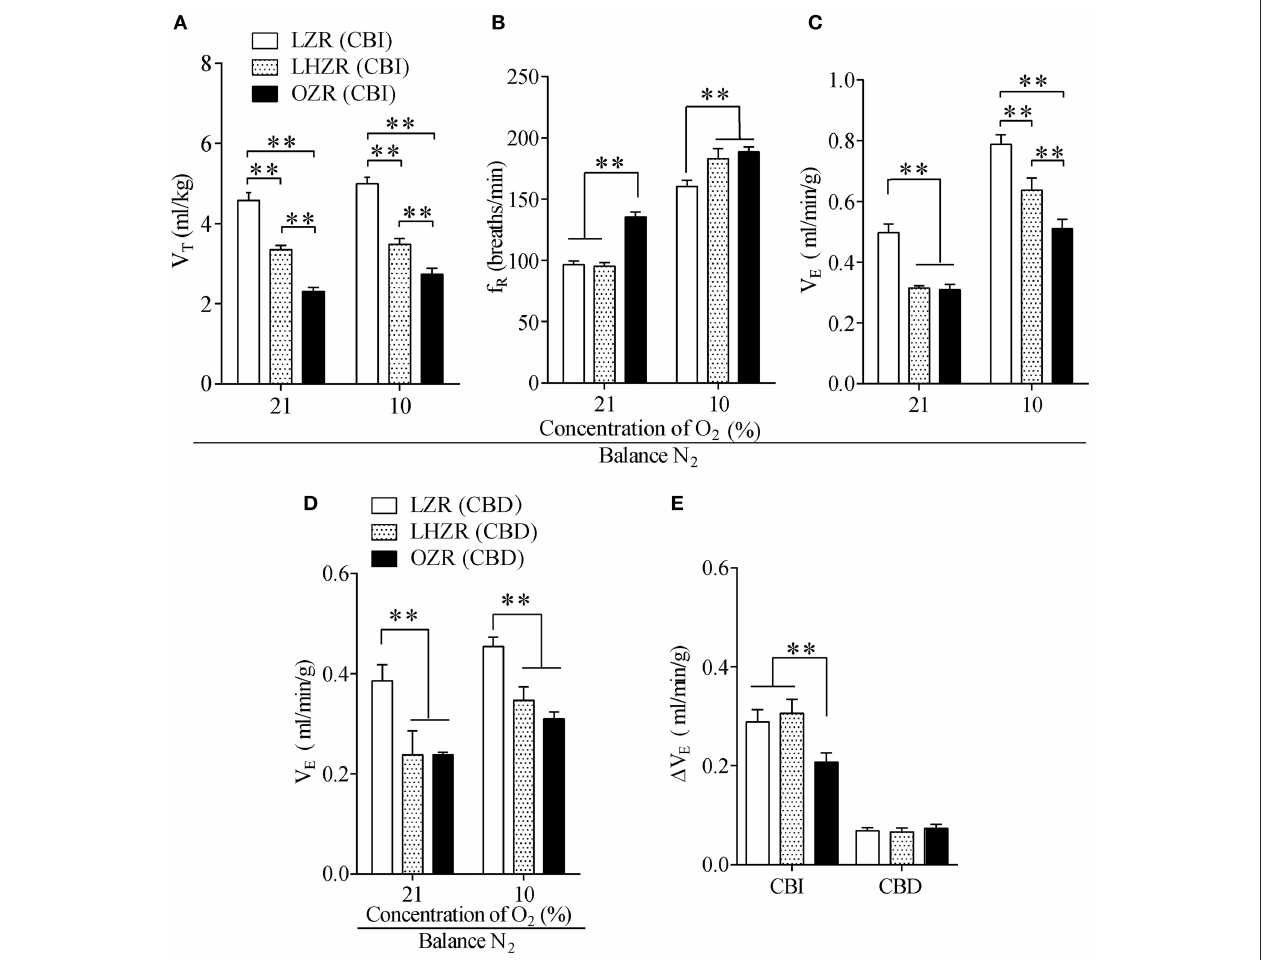
FIGURE 1 | The OZR exhibits impaired HVR. (A–C) Effect of hypoxia on V T , f R , and V E in the three groups of rats. (D) The stimulatory effect of hypoxia on V E in three groups of CBD rats. (E) Changes in V E during exposure to 10% O 2 between CBI and CBD rats. n = 20 for each group, ** P < 0.01 as drawn by two-way ANOVA with